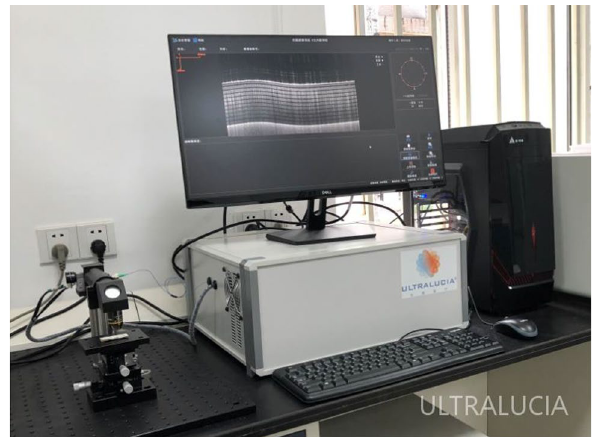
Figure 2. UL-D01-type optical coherence tomography